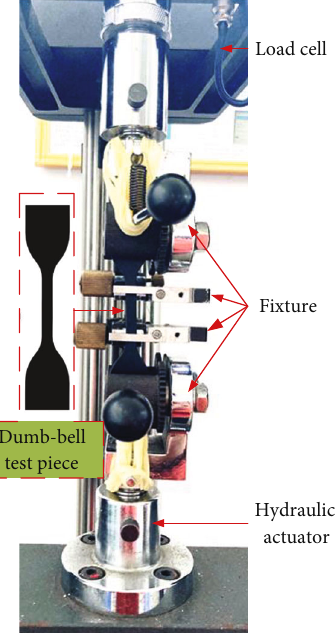
Figure 5: Uniaxial tensile test device.